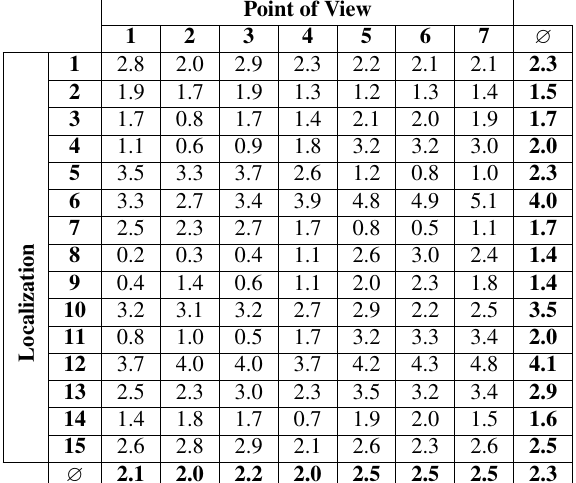
Figure 6. An ArUco marker is augmented with a manually positioned, blue virtual border. The images have been recorded with the HoloLens camera positioned in front of the marker while the camera is rotated subsequently to the left and to the right respectively. With increasing angle, an offset between the virtual rectangle and the physical marker is apparent that is not perceived by the user wearing the HoloLens device.